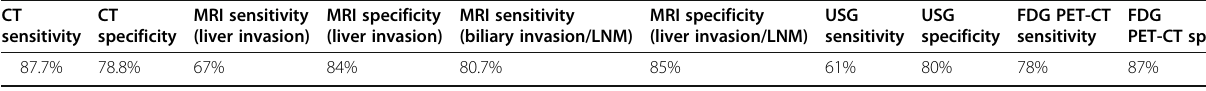
Table 5 Sensitivity and specificity of MDCT in detection of carcinoma of gall bladder